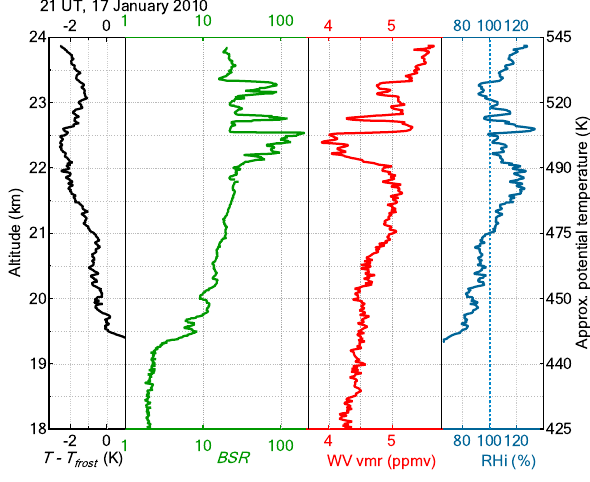
Fig. 1. Vertical profiles obtained during balloon descent on 17 Jan- uary 2010. From left to right: difference between the observed tem- perature and the “climatological” frost point (based on January mean water vapour from FPH and CFH soundings in 2002–2010, black line); backscatter ratio at 870nm (COBALD, green line); wa- ter vapour volume mixing ratio (FLASH-B, red line); relative hu- midity with respect to ice (based on water vapour from FLASH- B and temperature from the RS92 Vaisala radiosonde). The time stamp in the upper-left corner refers to the time of stratospheric